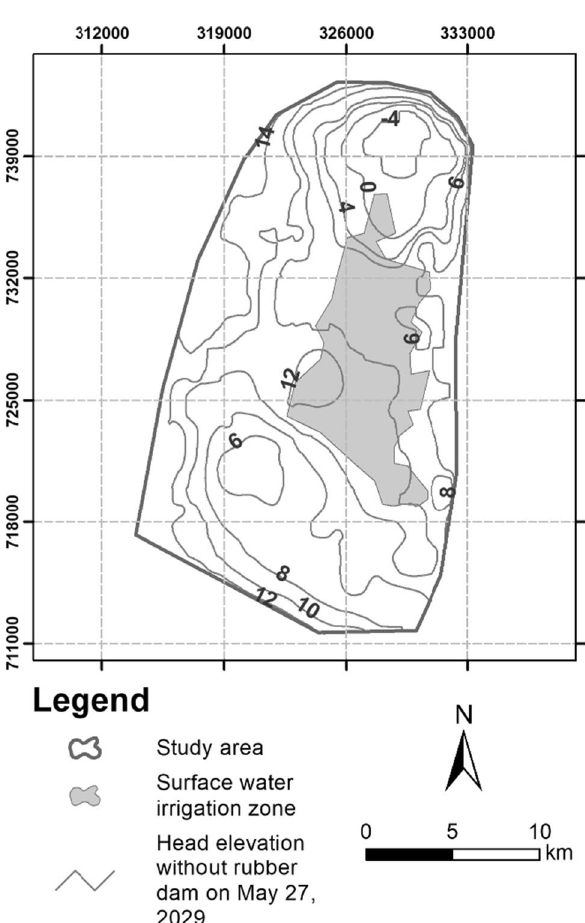
Fig. 9 GWL contour map of May 27, 2013, for scenario-0 showing the lowest GWL (-2 mPWD) to the north of the model area where Nachole and Gomastapur Upazilas are located. The highest GWL (16 mPWD) is seen to the west of the model domain